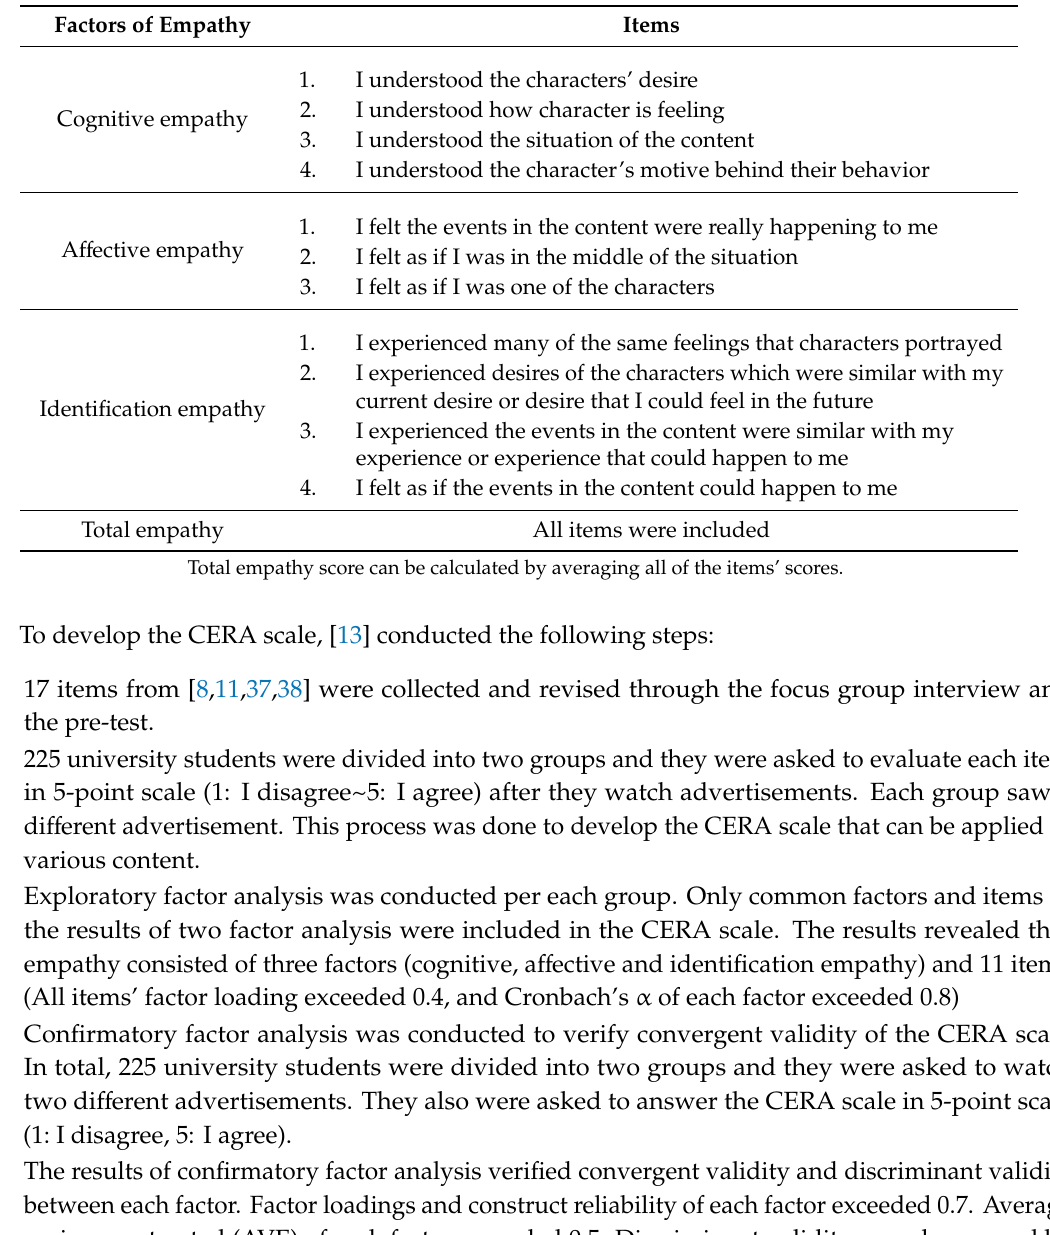
Table 2. Items of the Consumer Empathic Response to Advertising Scale (CERA) (empathy questionnaire). Factors of